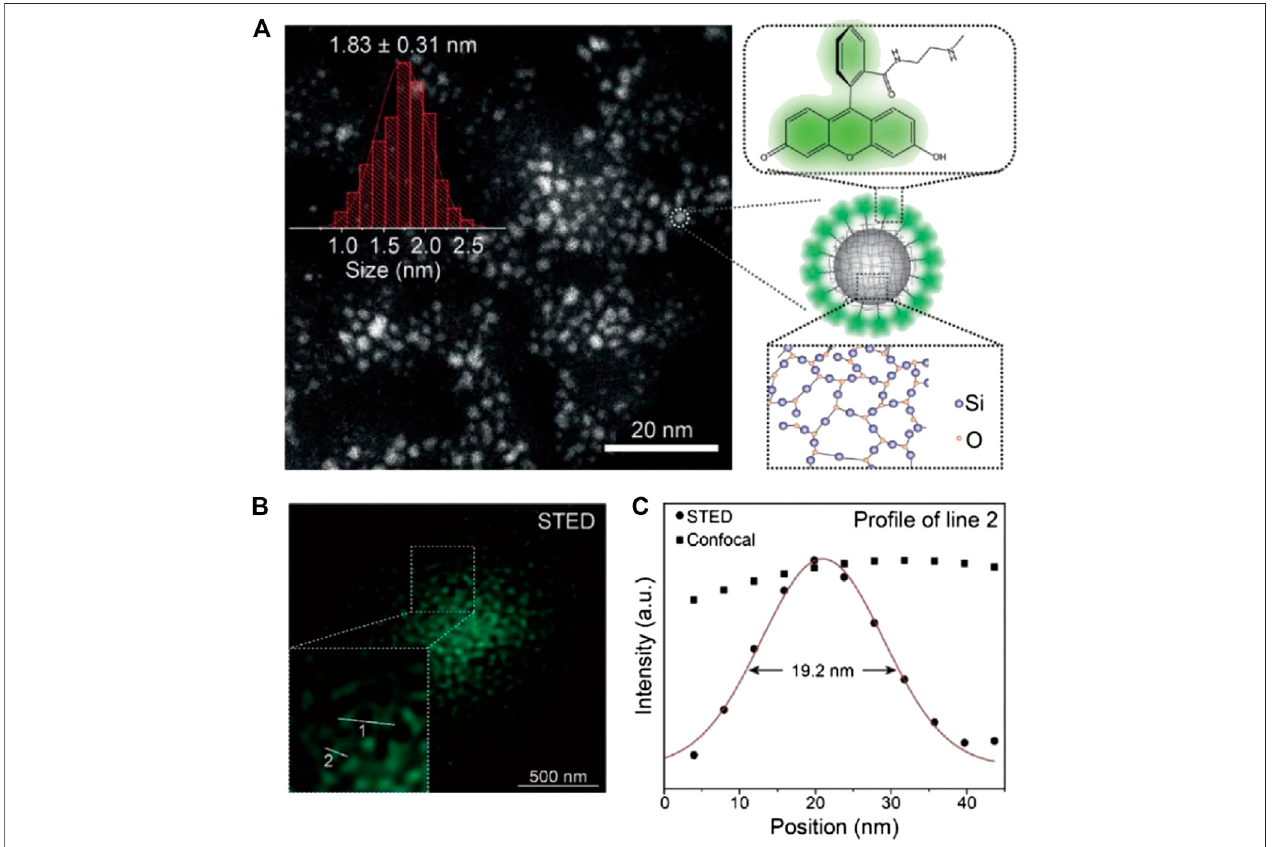
FIGURE 3 | Sub-2-nm dye-doped SiNPs for STED imaging (Liang et al., 2020). (A) The morphology and structure illustration of SiNPs. (B) The STED microscopy imageof dispersed SiNPs. (C) Theplot fi le ofsignal intensities for confocal and STED images. Aresolution of19.2 nm was calculated from the fullwidth at half maximum (FWHM) of the plot fi